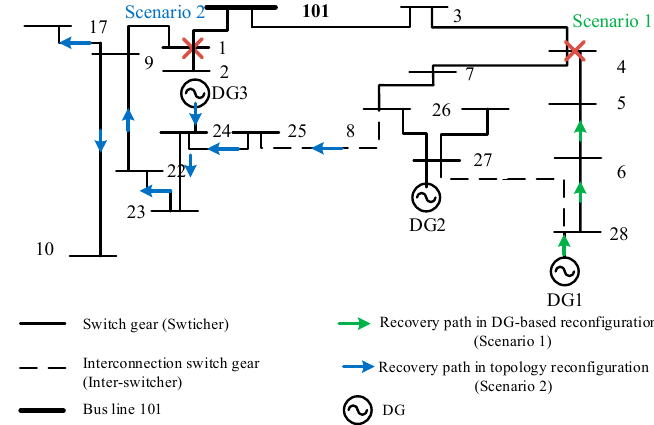
Figure 1. The illustration of supply restoration upon faults for two scenarios.